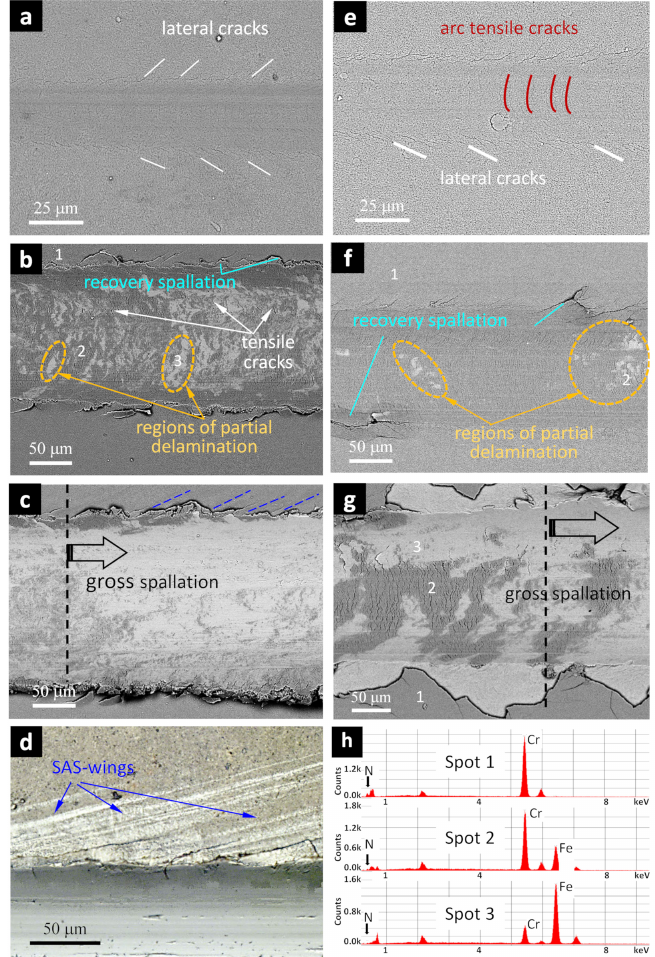
Figure 6. ( a – c ) SEM images of the characteristic damage mechanisms at the L C 1 , L C 2 , and L C 3 loadings for the simply coated sample, respectively; ( d ) magnified OM image of the SAS-wing region; ( e – g ) SEM images of the damage mechanisms at the L C 1 , L C 2 , and L C 3 loadings, respectively, for the duplex-coated specimen; ( h ) EDS spectra in some characteristic points of the scratched and intact regions, denoted by 1, 2, and 3 in the ( b , f , g ) insets of the